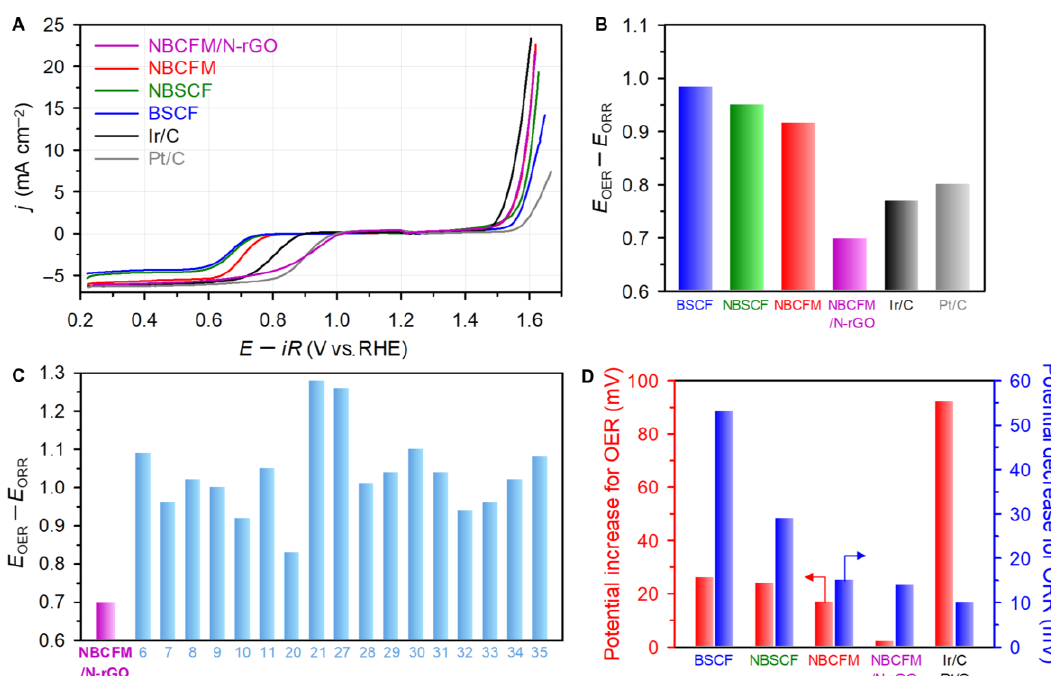
Figure 15. Bifunctional oxygen electrode activities and durabilities of the perovskites, NBCFM/N-rGO, and precious metal catalysts. ( A ) OER/ORR polarization curves for perovskite-based catalysts and precious metal catalysts. ( B ) Oxygen electrode activities (E OER − E ORR ) of perovskite-based catalysts and precious metal catalysts. ( C ) Comparisons of oxygen electrode activities of NBCFM/N-rGO with the previously reported bifunctional catalysts. The numbers on the x -axis denote reference numbers. ( D ) OER potential increase and ORR potential decrease of perovskite-based catalysts and precious metal catalysts after durability tests. Copyright by the American Association for the advancement of Science [99].